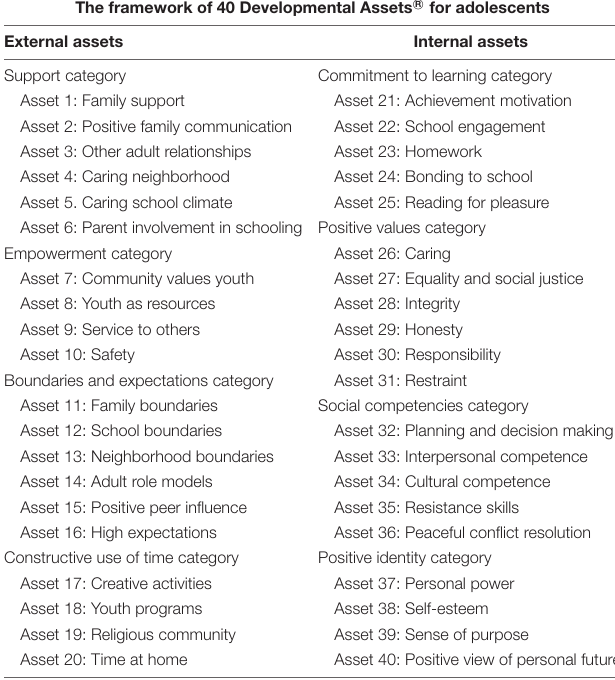
TABLE 1 | The framework of 40 Developmental Assets R (cid:13) for adolescents. The framework of 40 Developmental Assets R (cid:13) for adolescents External